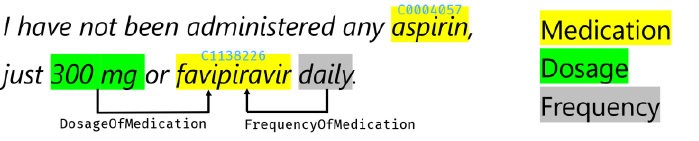
Figure 3. The example of entity/relation metadata text markup. The medications are highlighted in yellow, the dosages are highlighted in green, the frequencies are highlighted in grey.